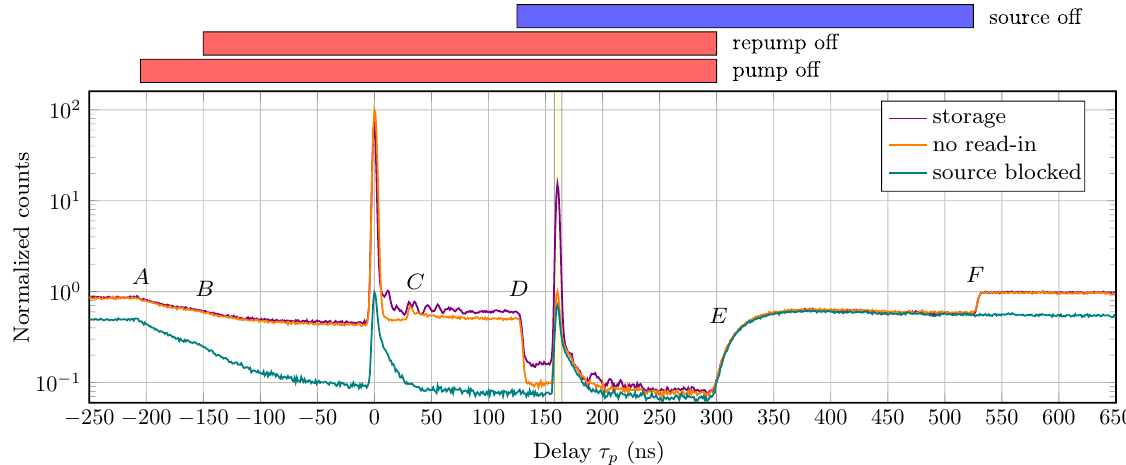
FIG. 4. Photon arrival-time histograms for storage experiments on a log scale. The data are histogrammed in 1 ns (12 × 81 ps) bins, and τ p = 0 represents the time at which an input photon arrives at the detector if it leaks through the setup without being stored or lost. The y axis is normalized to the peak of the no read-in curve in the retrieval window (8325 counts) to yield a proxy for the worst-case signal-to-noise ratio, and is plotted logarithmically so that small features, labeled A – F , can be identified. These illustrate the experimental sequence and are described further in the main text. Colored bars above the plot signify the time windows in terms of detection time wherein the state preparation beams and the photon source are effectively turned